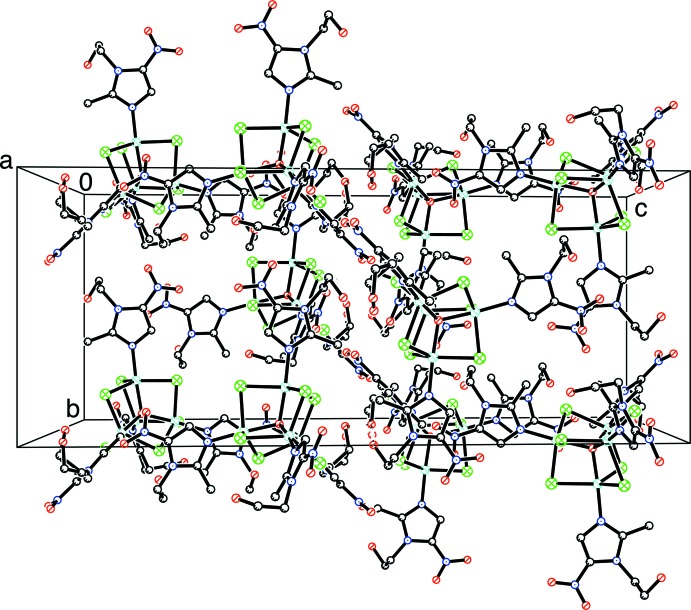
Unit-cell packing of [Cu4Cl6O(MET)4] viewed down [100].